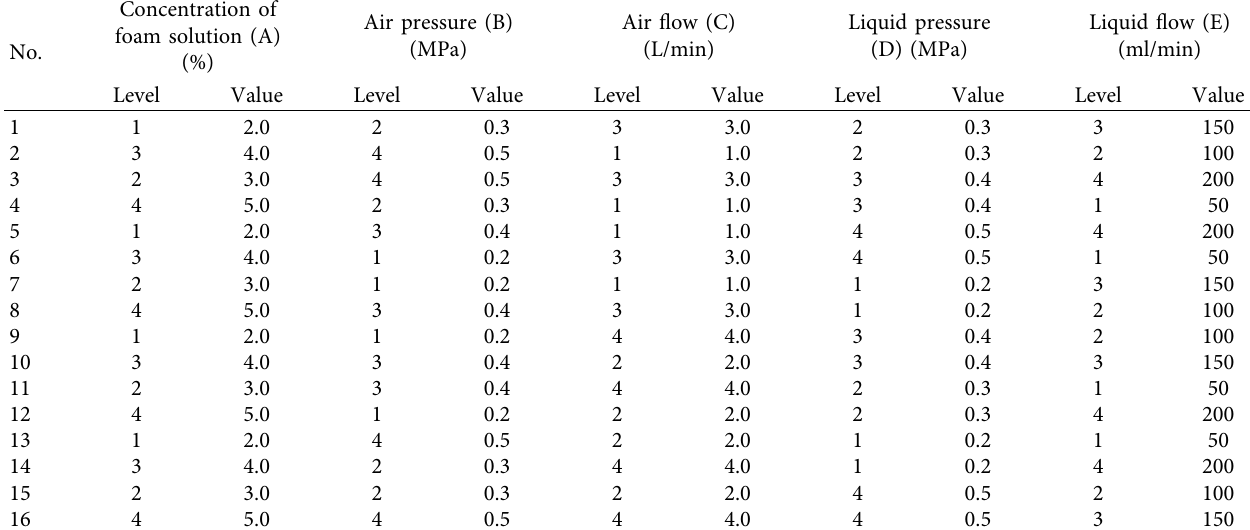
Table 3: Scheme of orthogonal